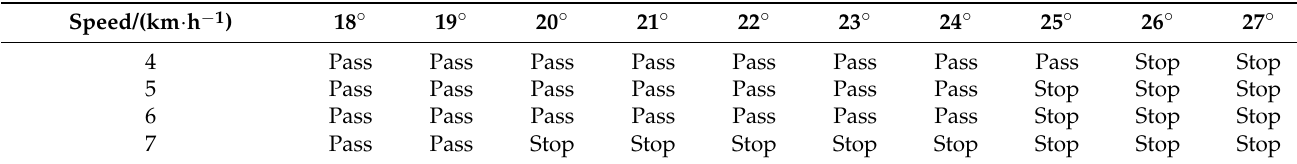
Table 2. Simulation experiment on a climbing track.